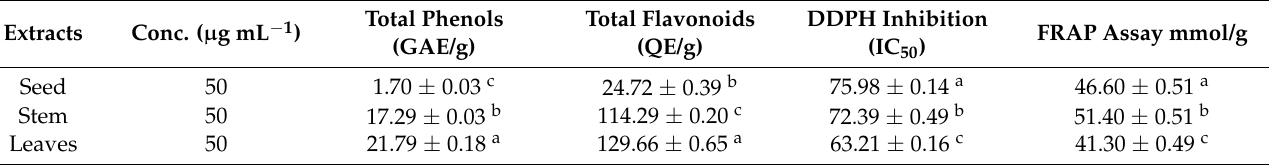
Table 3. Total phenols, flavonoids content and DPPH inhibition % of S. marianum .